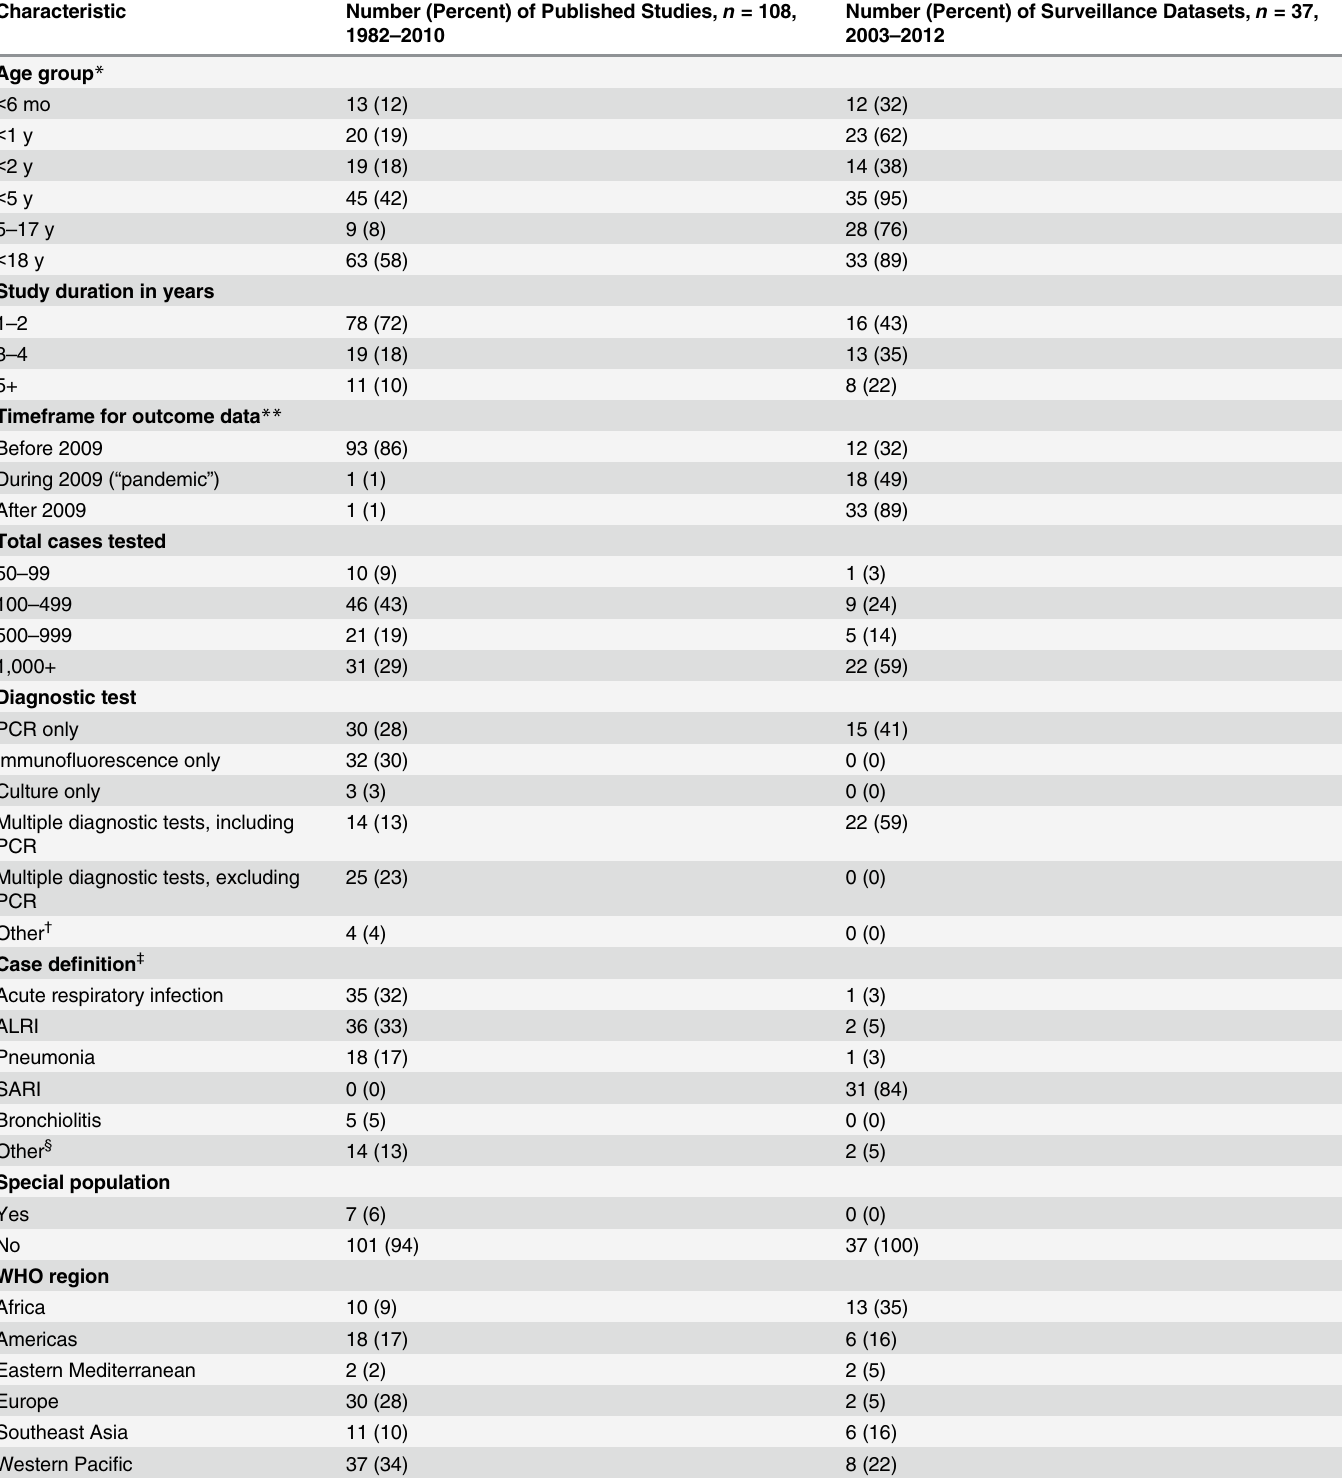
Table 1. Characteristics of published studies and surveillance data sources about influenza-associated respiratory illness among hospitalized children, 1982 – 2012.